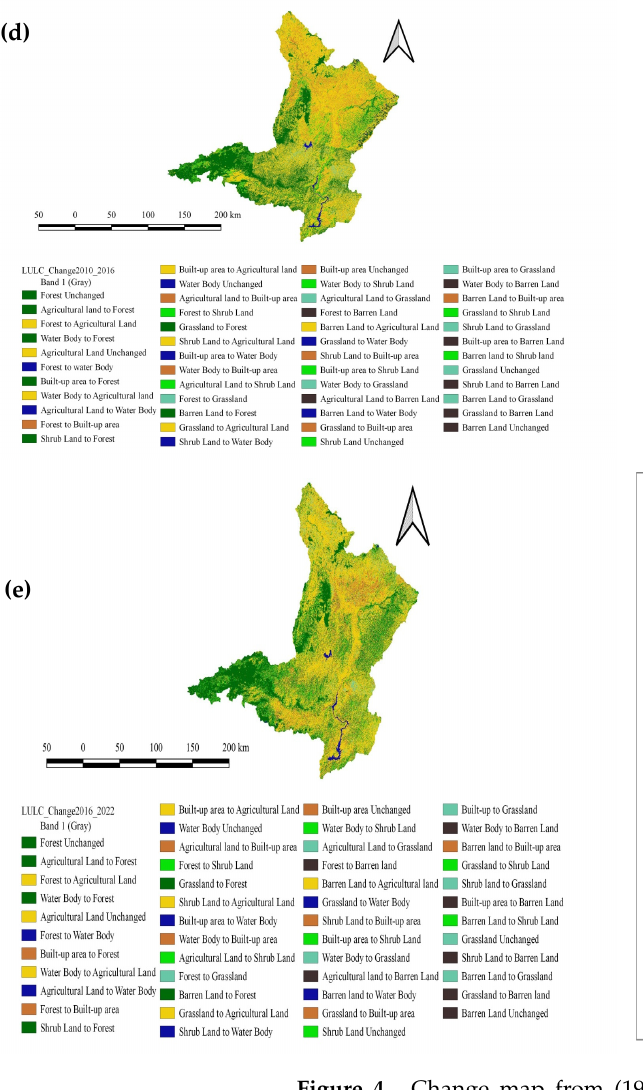
Figure 4. Change map from (1991–2022), ( a ) LULC changes (1991–1997), ( b ) LULC changes (1997–2004), ( c ) LULC changes (2004–2010), ( d ) 2010–2016, and ( e ) LULC changes (2016–2022). Table 5. LULC area (km 2 ) from 1991 to